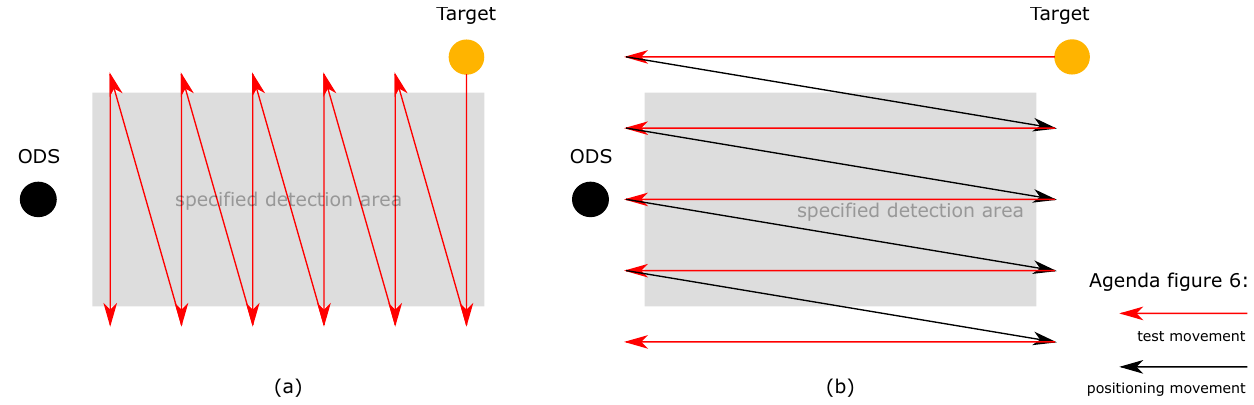
Figure 6. In the second test scenario, the ODS is in static state and the test target in dynamic state. The test scenario is divided in a lateral and longitudinal part: ( a ) In the lateral part, the test target is moved into the SDA from the left and right in a “zig-zag” movement from the ODS’s point of view; ( b ) in the longitudinal part, the test target is moved from front to back in a “zig-zag” movement into the SDA of the ODS from the point of view of the